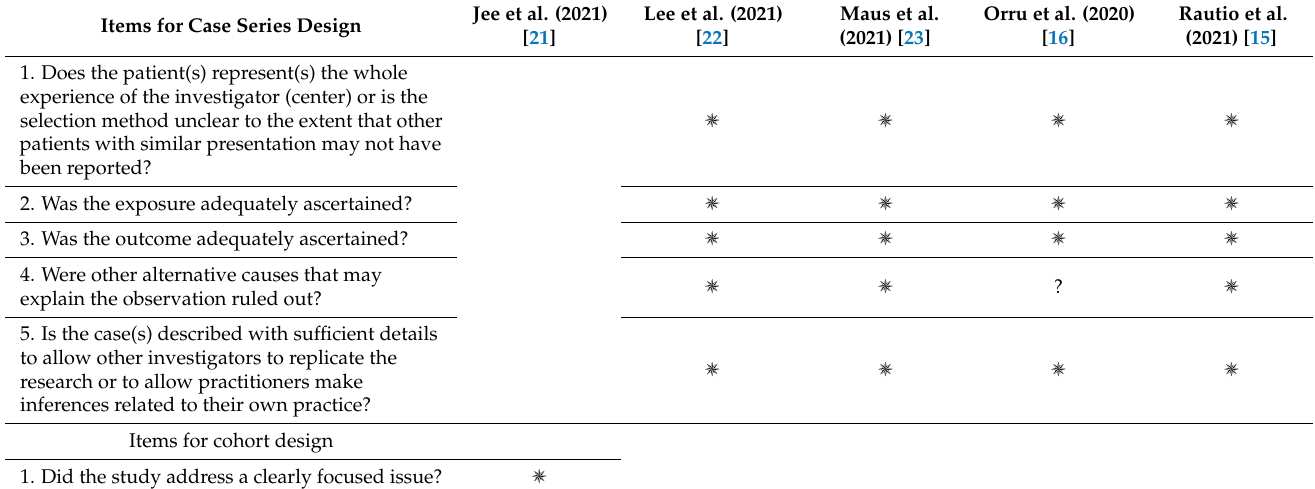
Table 1. Quality assessment of included